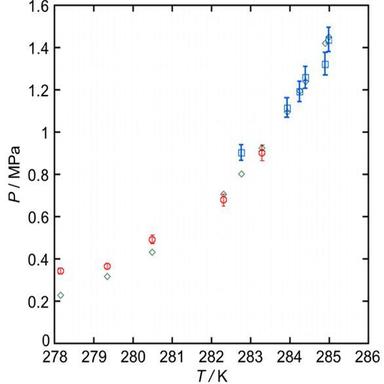
Phase equilibrium conditions of hydrates formed in (H2 + CO2) gas + THP + water system which is only considered with CO2 partial pressure and those in CO2 + THP + water system. , (H2 + CO2) gas + THP + water system around H2:CO2 = 0.9:0.1 (This study); , (H2 + CO2) gas + THP + water system around H2:CO2 = 0.7:0.3 (This study); , calculated phase equilibrium conditions in CO2 + THP + water system.